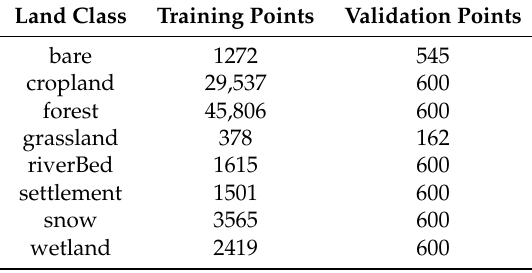
Table A1. Training point